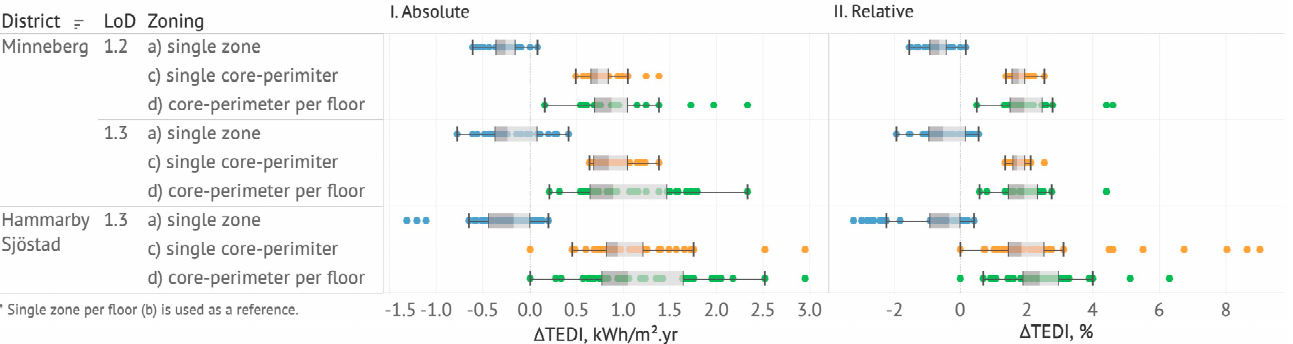
Figure 12. Absolute ( I ) and relative ( II ) change in thermal energy demand intensity (TEDI) for buildings in Minneberg (LoD 1.2 and LoD 1.3) and Hammarby Sjöstad (LoD 1.3) districts with single zone (a), single core − perimeter (c), and core-perimeter per floor (d) zoning applied. Single zone per floor (b) was used as a reference.